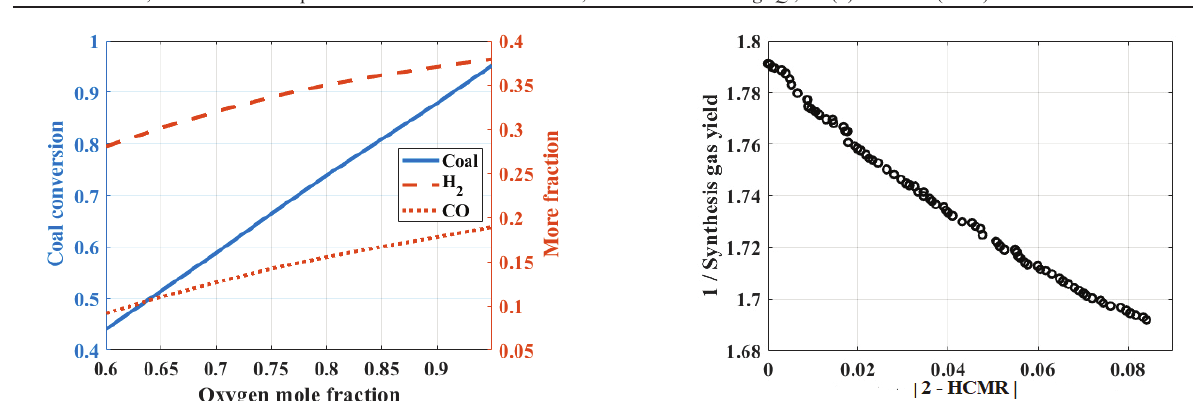
Fig. 7 – Effects of oxygen mole fraction in inlet-air on outlet solid conversion and synthesis gas composition